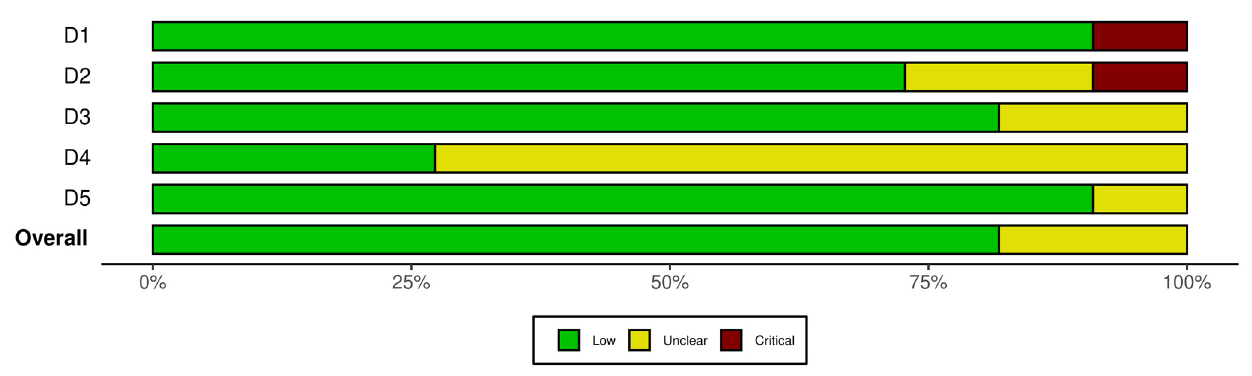
Figure 2. Risk-of-bias plot.